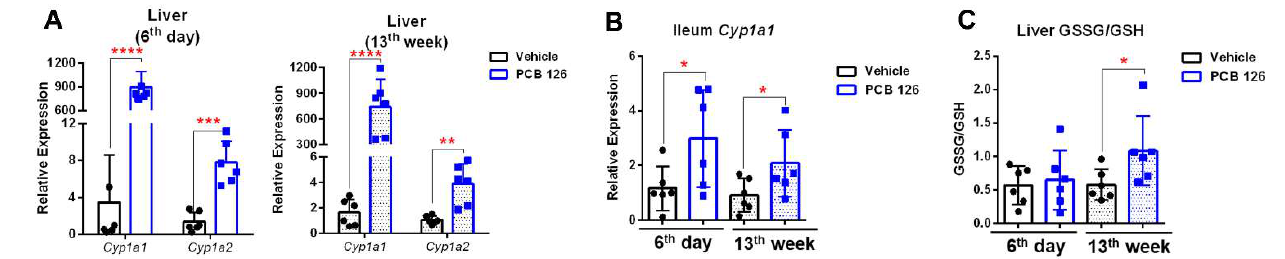
Figure 1. Effects of early-life PCB 126 exposure on AHR signaling and redox status. ( A , B ) qPCR analysis of mRNA levels of AHR target genes in the liver ( A ) and ileum ( B ) from mice with vehicle or PCB 126 exposure. ( C ) Ratio of oxidized glutathione (GSSG) to reduced glutathione (GSH) in the liver from mice with vehicle or PCB 126 exposure. Values are means ± S.D. ( n = 6 per group). * p < 0.05, ** p < 0.01, *** p < 0.001, **** p < 0.0001 compared to vehicle.